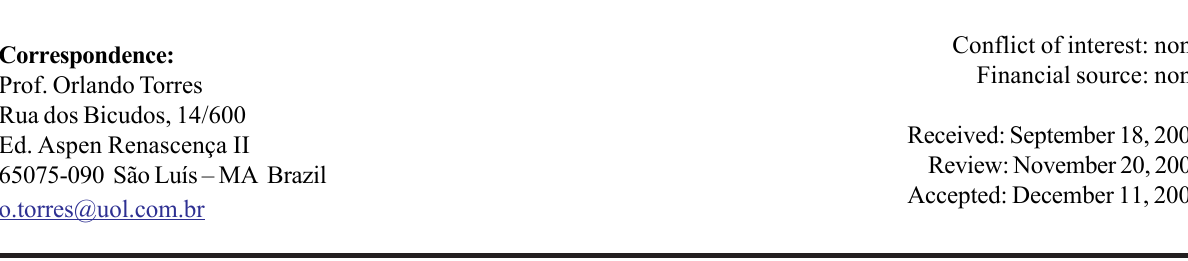
*Color figure available from